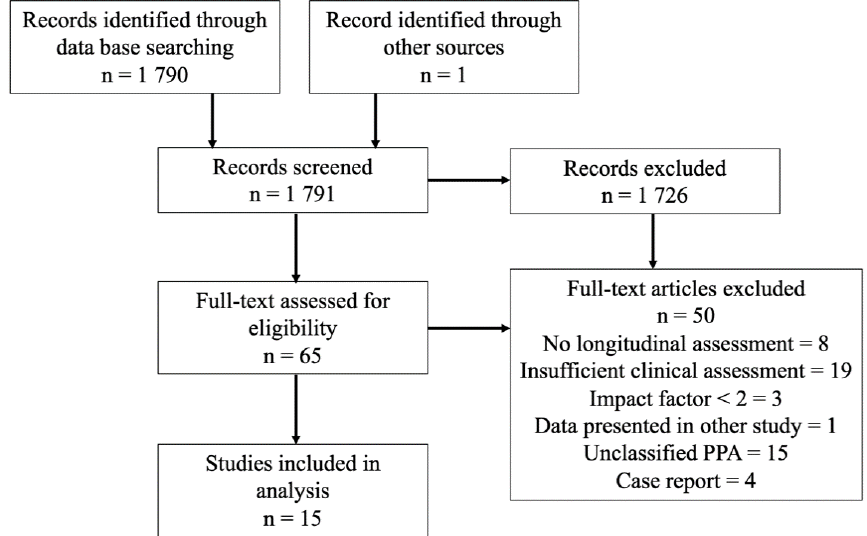
Figure 1. Flowchart of the selection procedure.